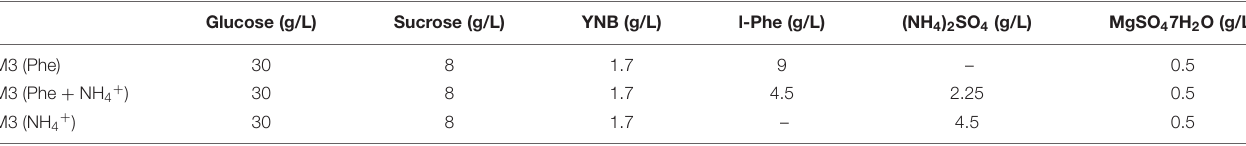
TABLE 1 | The compositions of the cell culture media used to produce 2-PE in this study. Glucose (g/L) Sucrose (g/L) YNB